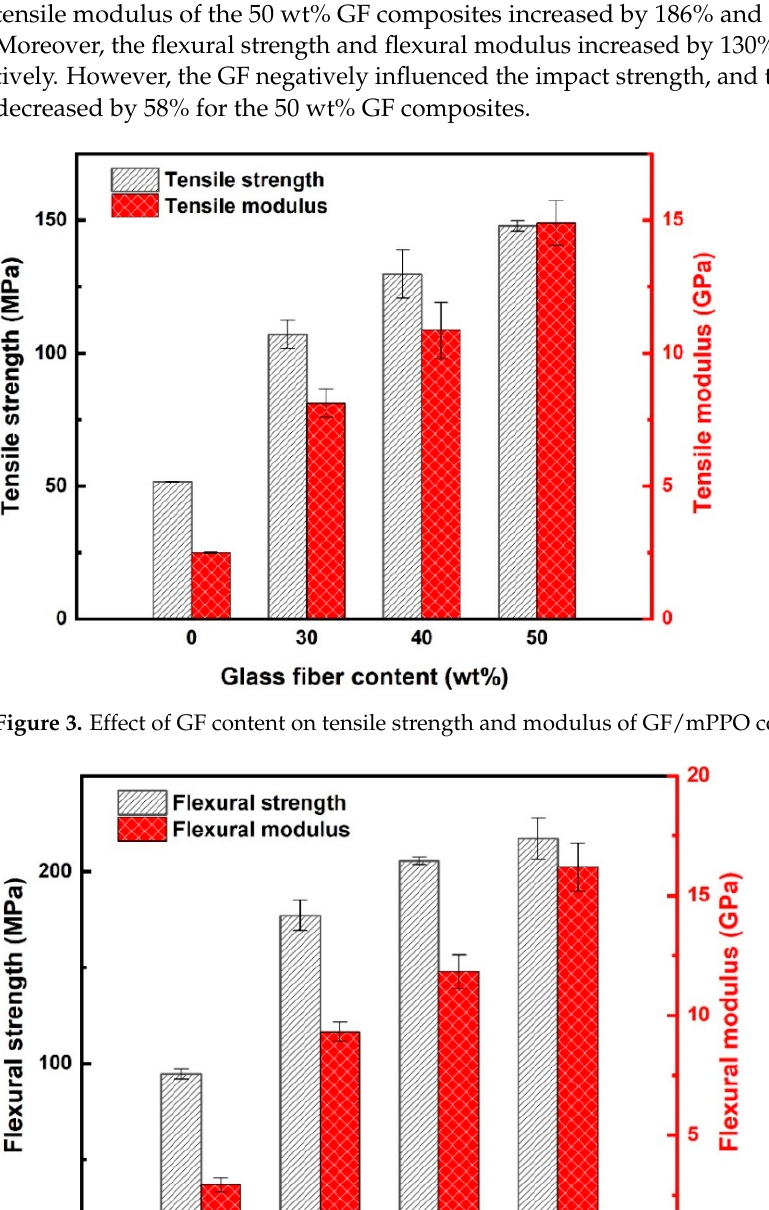
Figure 2. The cross-section images of GF/mPPO composites (the scale bar is 500 μ m); ( a ) GF/mPPO 30, ( b ) GF/mPPO 40, and ( c ) GF/mPPO 50.